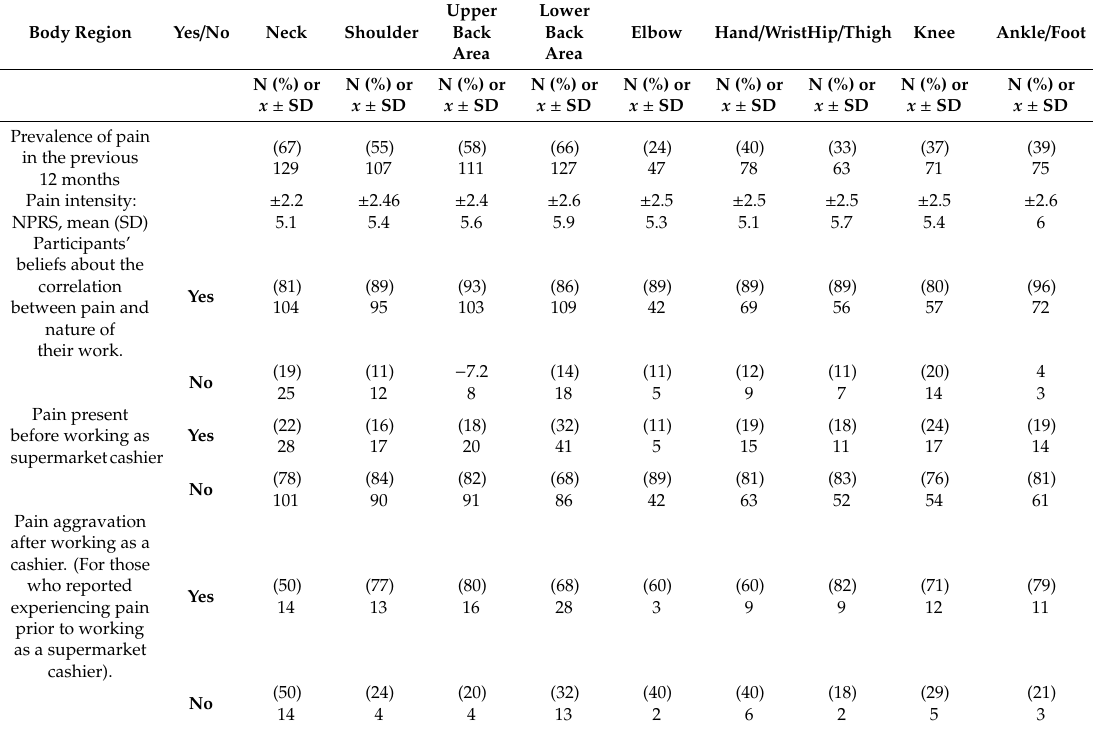
Table 4. Details of prevalence of MSD symptoms in the body regions.